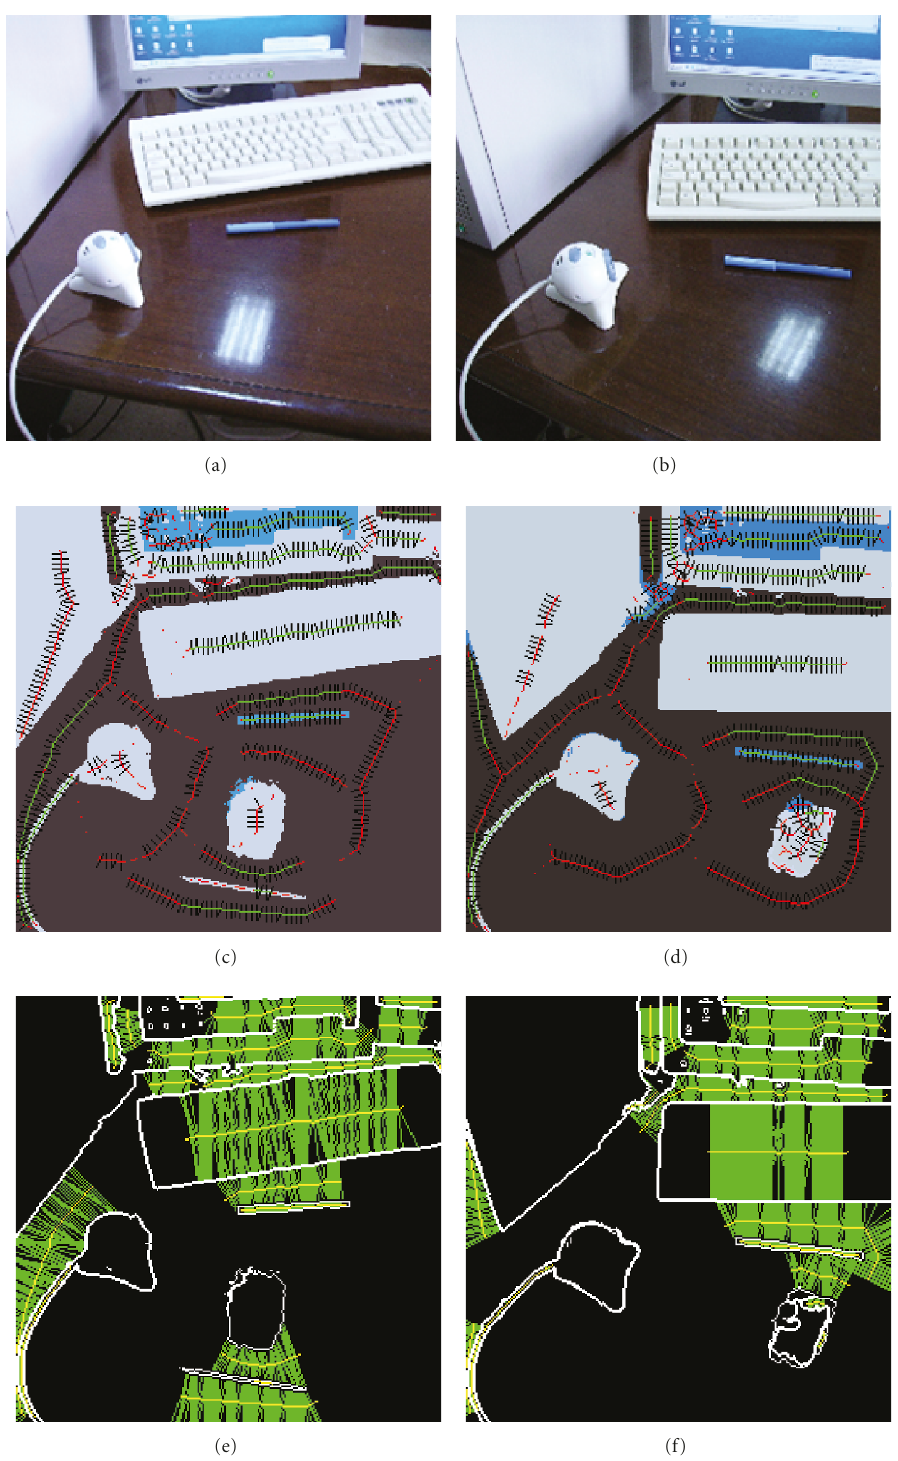
Figure 7: Detection test with a complex image seen from di ff erent viewpoints. Several interesting objects as the ball pen, keyboard, and webcam cable have been detected in both images. (a)-(b) Original images; (c)-(d) segmented images with the points of the skeletons and the normal vectors. Green points mean skeletons with curvilinear properties and red points skeletons without curvilinear properties. (e)-(f) Final results are depicted (region colours have not been represented for a clearer representation). The curvilinear skeletons are drawn with the normal vectors prolonged to see the crosspoints with the